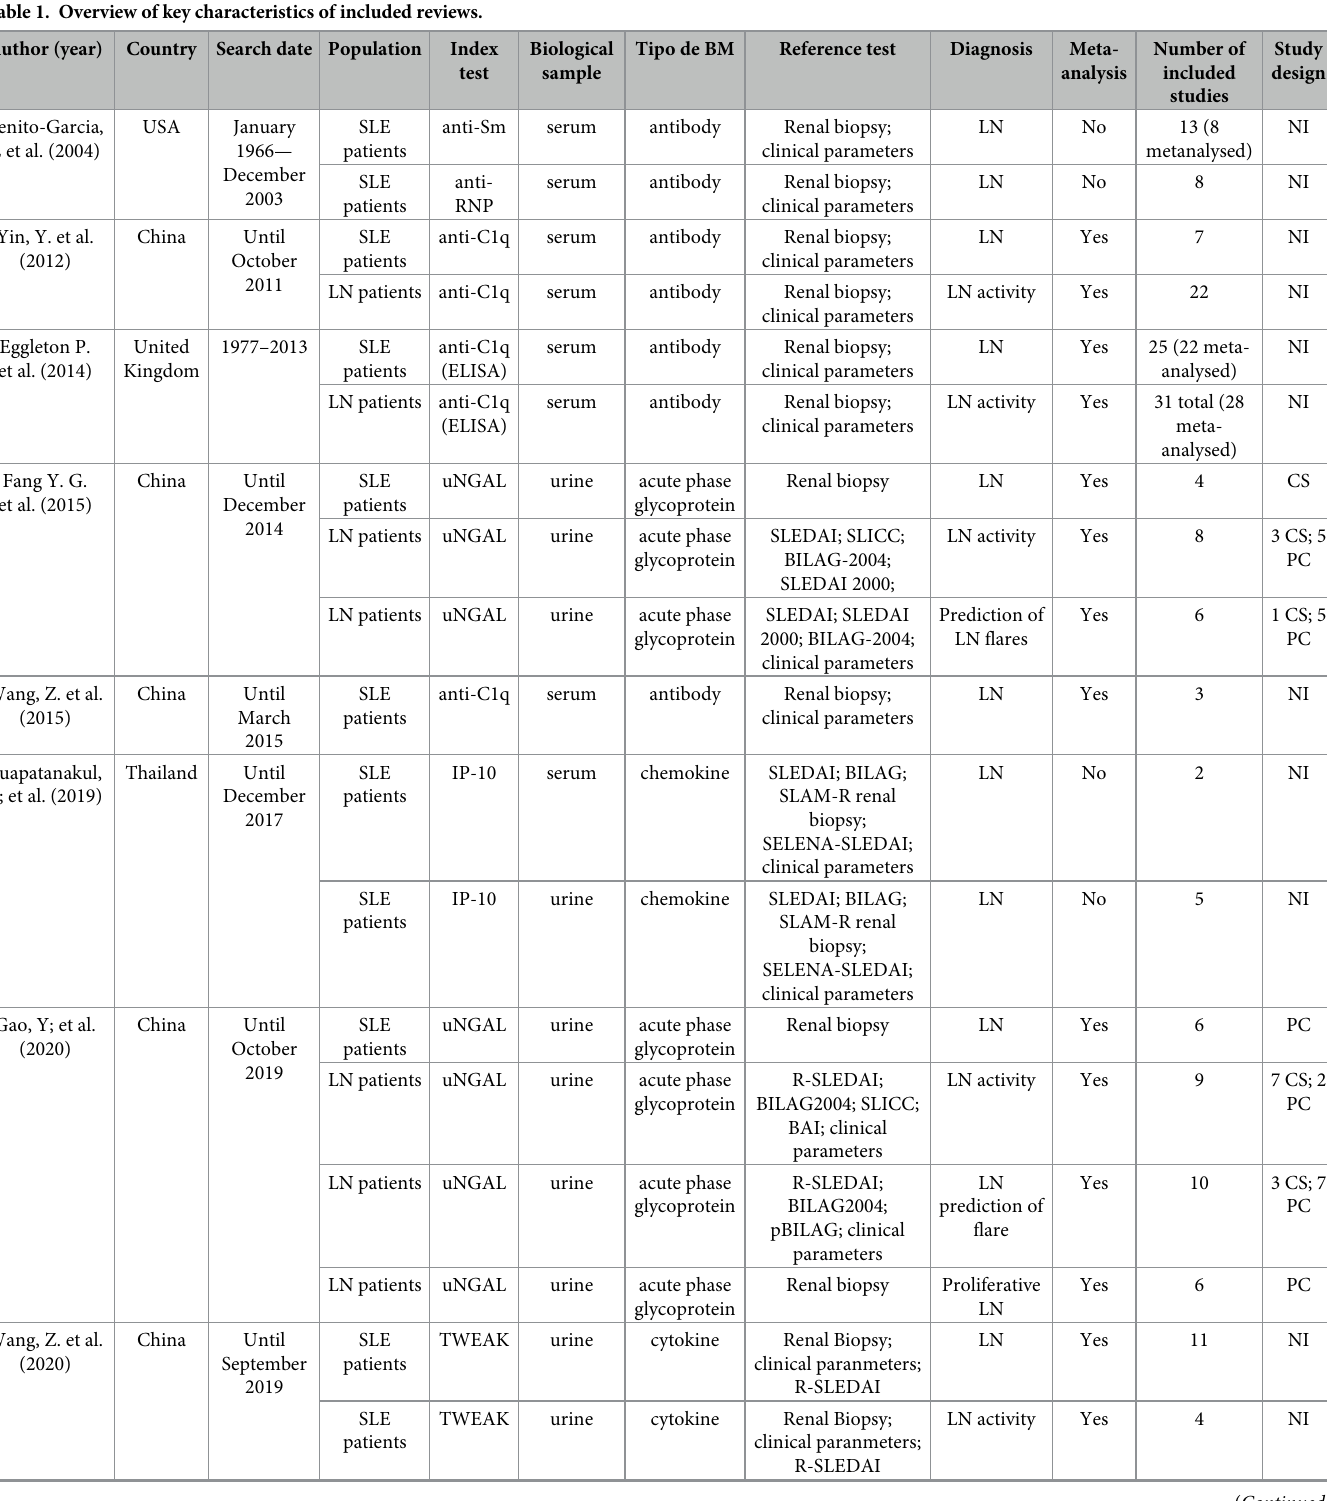
Table 1. Overview of key characteristics of included